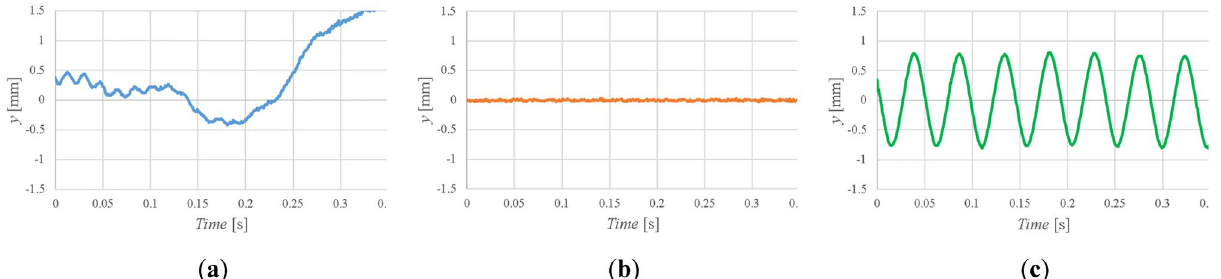
Figure 4. Time variations of the center of gravity of the javelin in the y-direction: ( a ) without the notch filter; ( b ) with the notch filter; ( c ) with a weak notch